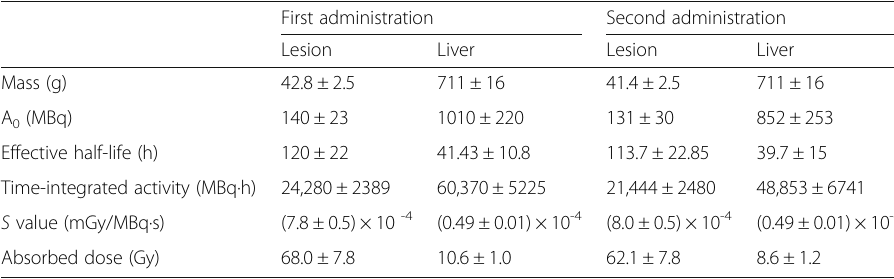
Table 2 Results of the absorbed dose calculation to normal liver and to